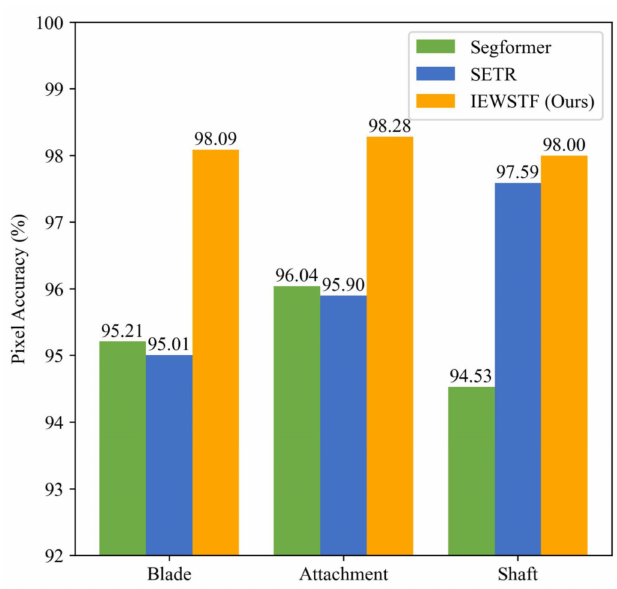
Figure 3. Comparison of PA for all methods in each semantic